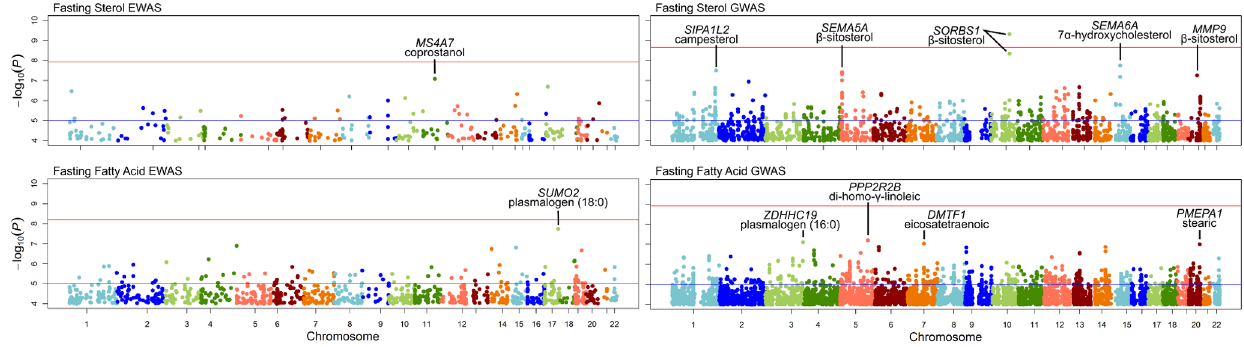
Figure 2. Manhattan plots for markers with P , 0.0001 from epigenome-wide association study and genome-wide association study. Phenotypes include 11 sterols and 35 fatty acids measured at fasting.